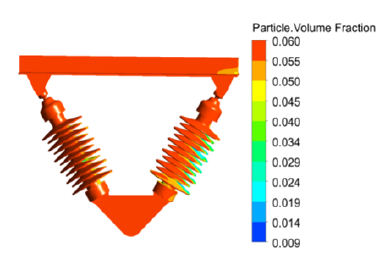
Figure 16. Distribution map of contamination on the surface of insulators with a concentration of 0.06 mg/m 3 .